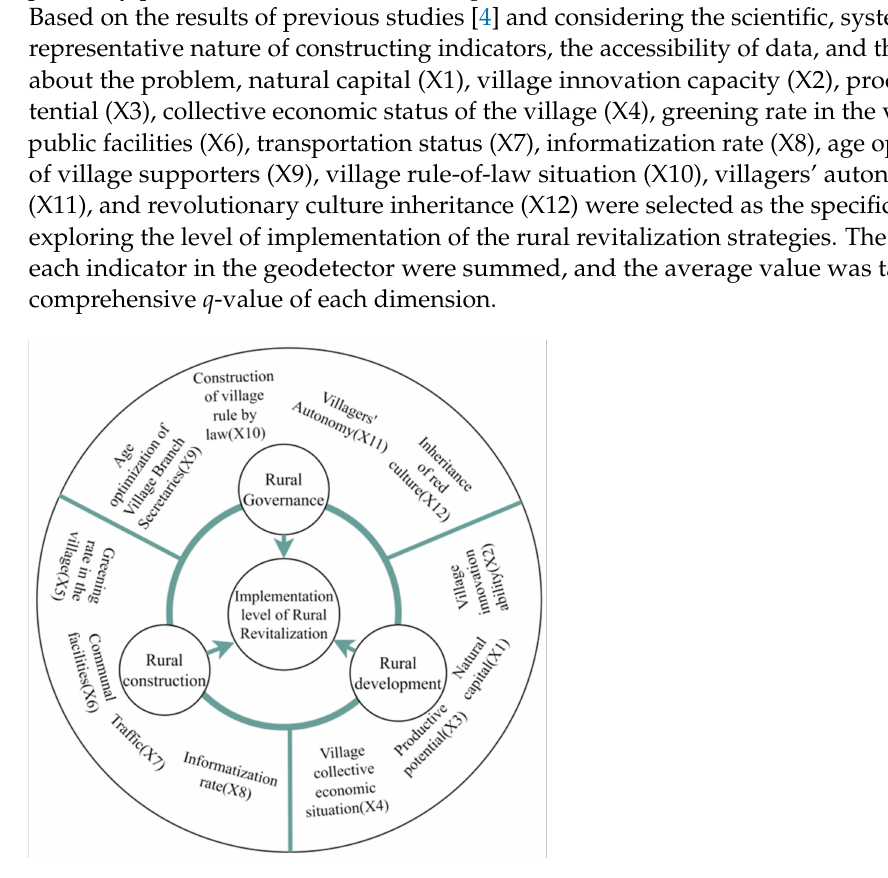
Figure 4. Factors influencing the rural revitalization level in the Jinggangshan rural revitalization demonstration